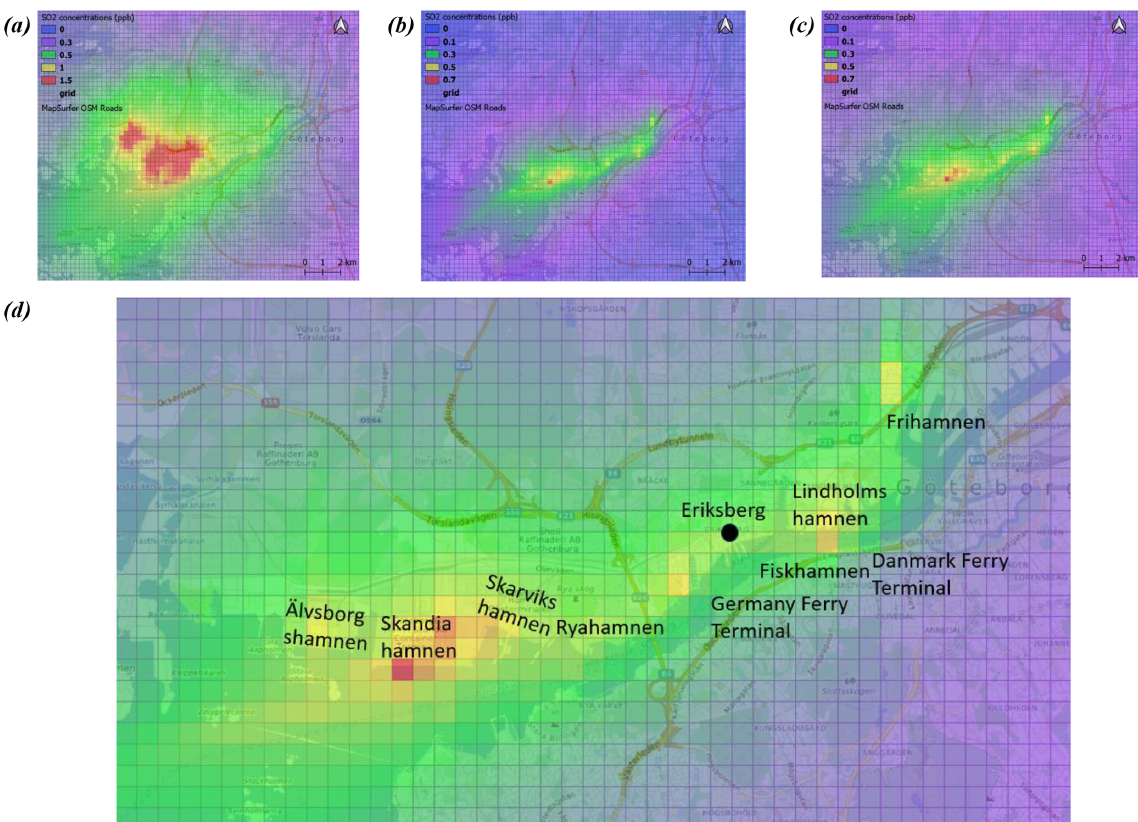
Figure 6. Simulated atmospheric concentrations of SO 2 (in ppb) for the year 2012: (a) annual mean concentrations in the base case simu- lation, (b) annual mean contribution of local shipping, (c) annual mean contribution of local and regional shipping and (d) same as (c) but with main ports along the Göta älv as well as Eriksberg. Base map credits: © OpenStreetMap contributors 2020. Distributed under a Creative Commons BY-SA License.